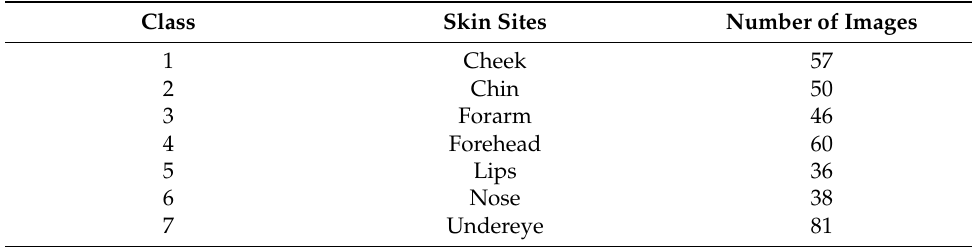
Table 4. The modified ultrasound images at different skin sites.